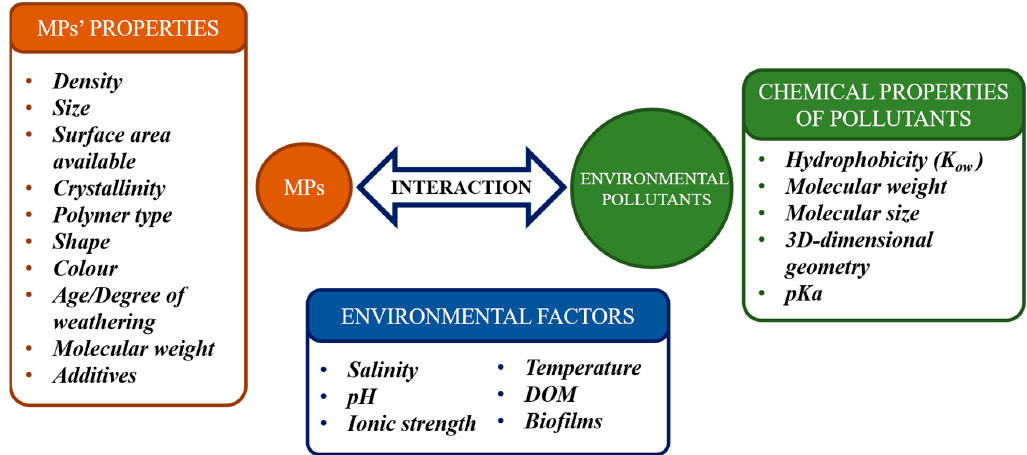
Figure 2. Summary of the main factors influencing the interaction between MPs and chemical